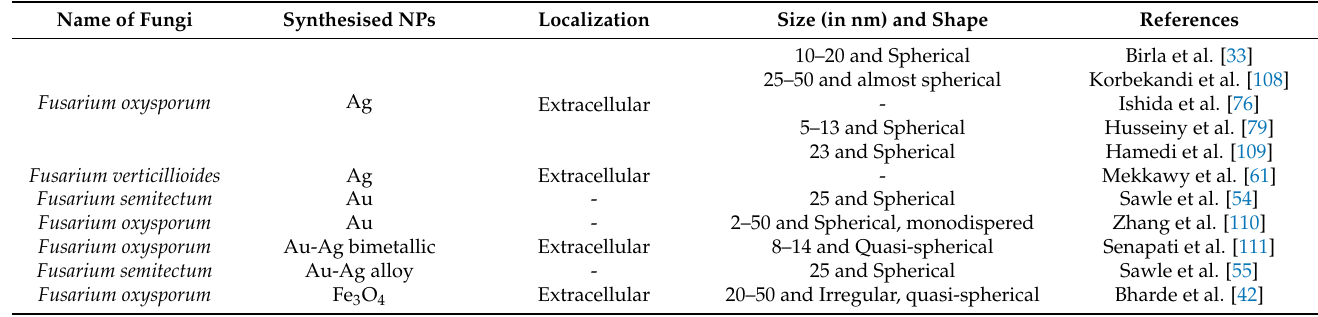
Table 2. Fusarium isolates used in the green synthesis of different